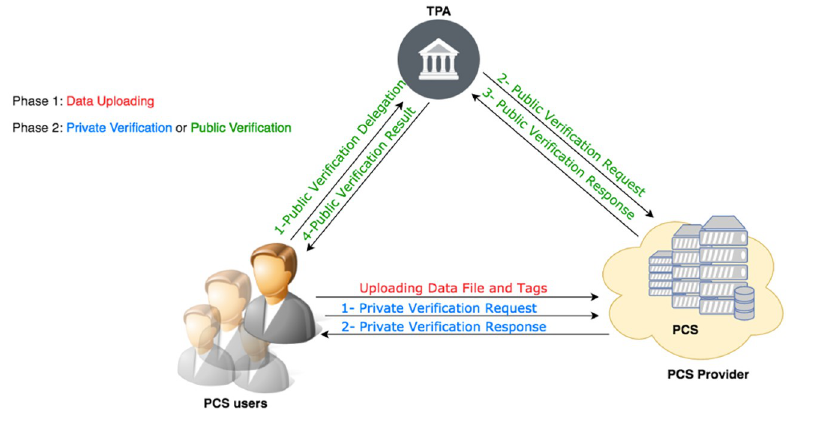
Fig 1. The DIA system